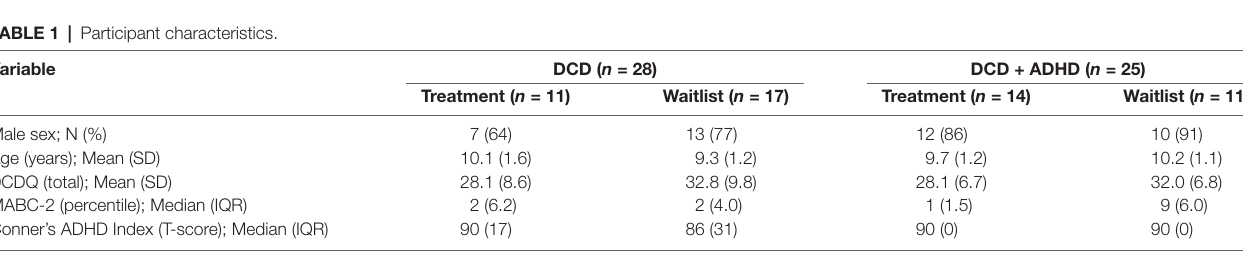
TABLE 1 | Participant